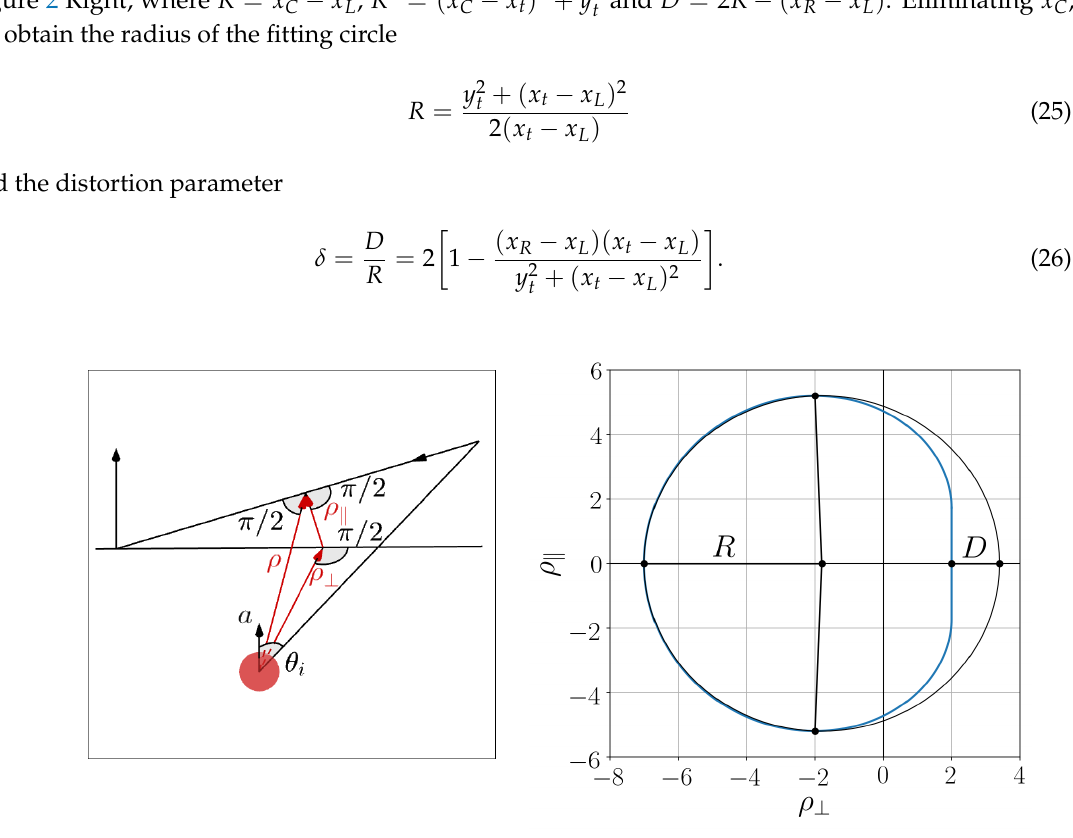
Figure 2. Left : Impact parameters ρ ⊥ and ρ || corresponding to the celestial coordinates x , y . Right : Asymmetry parameter D